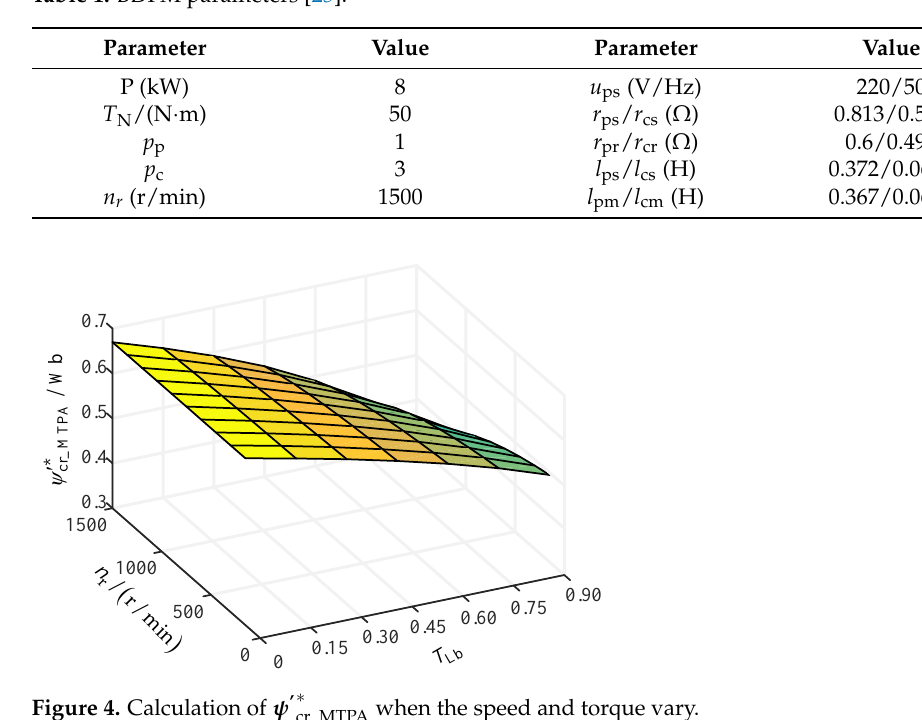
Figure 4. Calculation of ψ ’